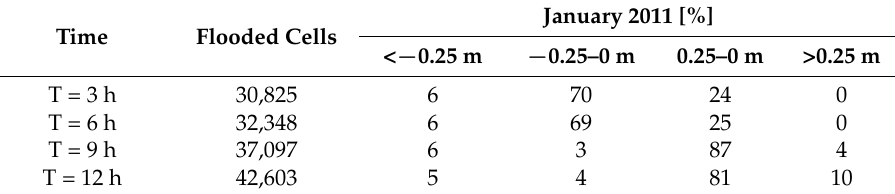
Table 9. Percentage of inundated cells at the advective event in January 2011.